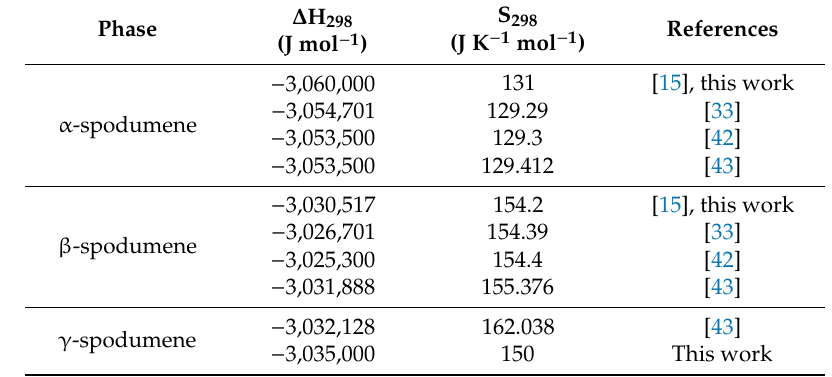
Table 7. Summary of spodumene phase data ( ∆ H 298 and S 298 ) .